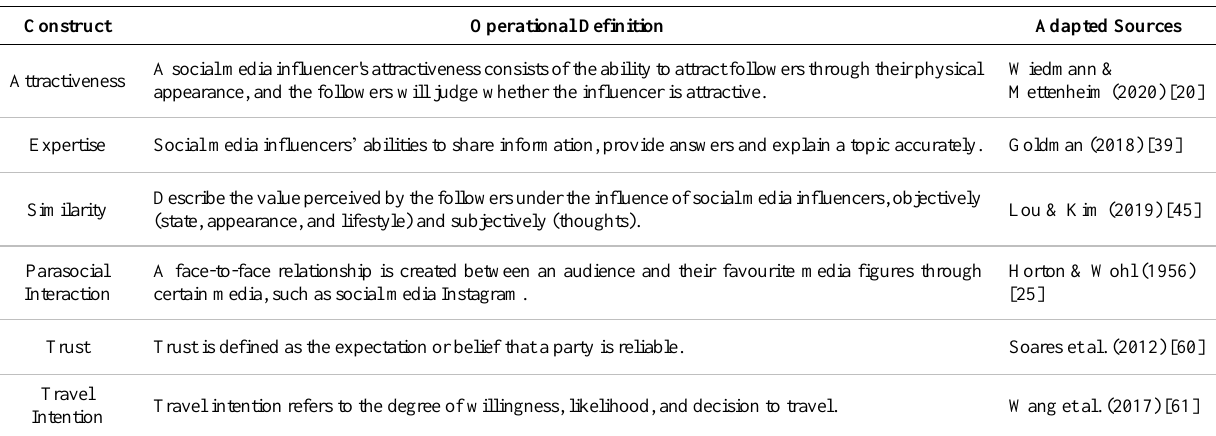
Table 1. Constructs